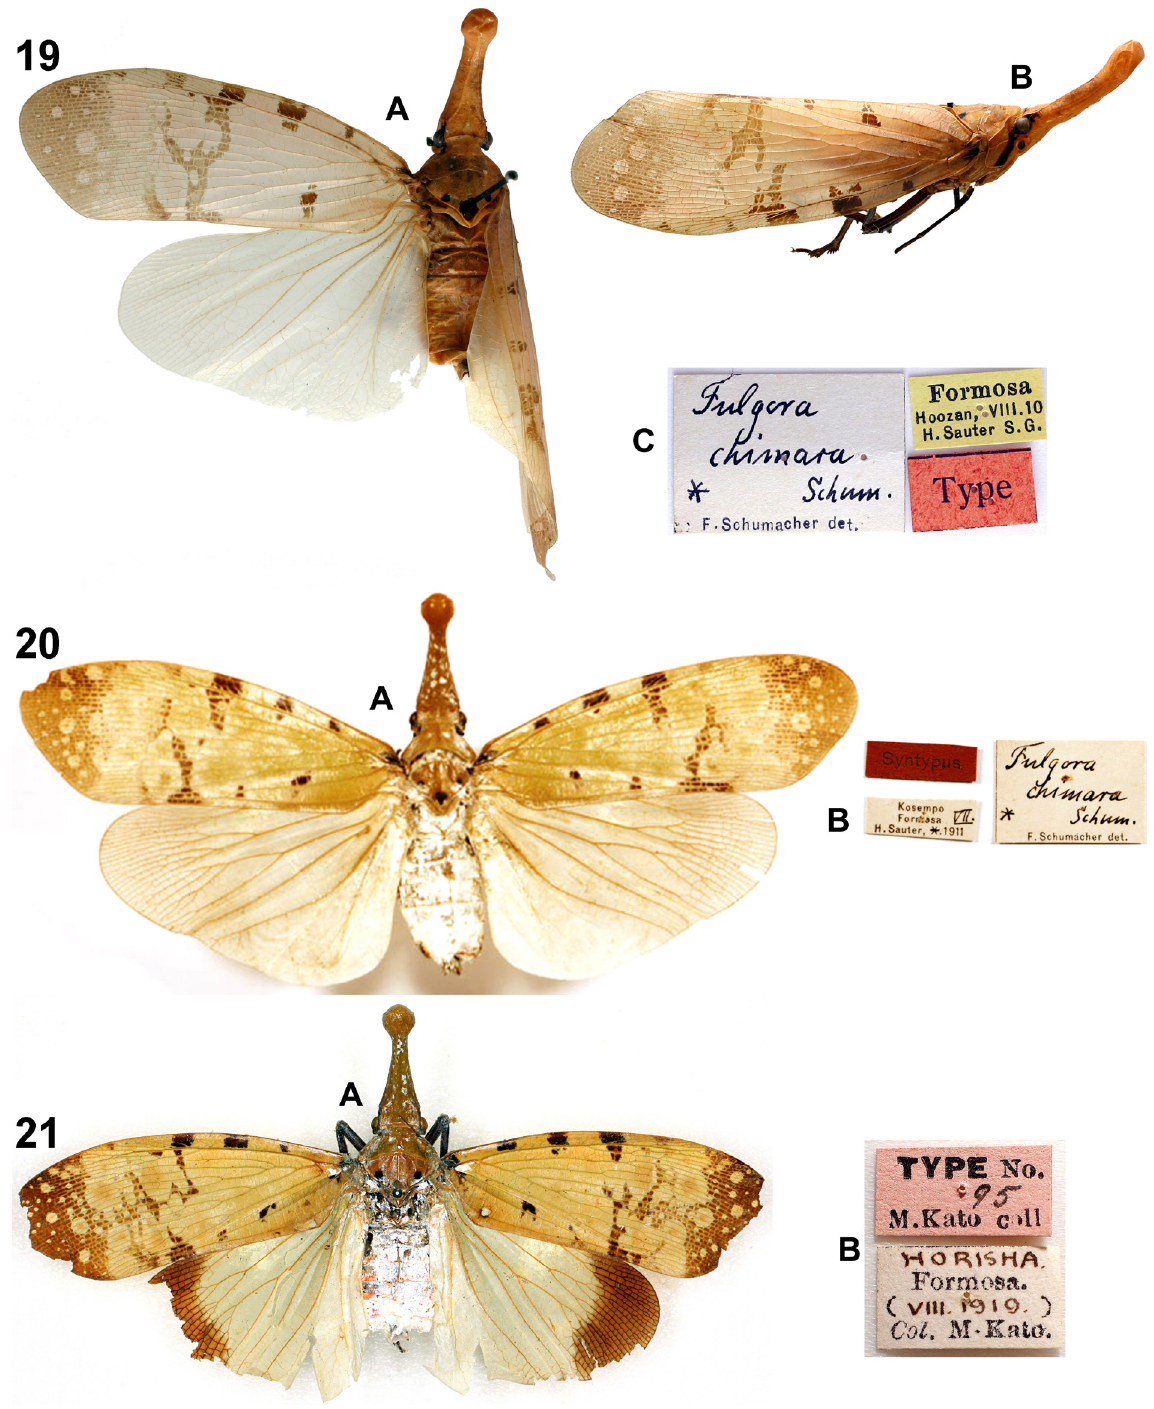
Figs 19–21. Pyrops watanabei (Matsumura, 1913), type specimens of the synonymised taxa. 19– 20 . Fulgora chimara Schumacher, 1915. 19 . Lectotype, ♀ (MFNB, photographs by J. Constant). A . Habitus, dorsal view. B . Habitus, right lateral view. C . Labels. Total length: 37 mm. 20 . Paralectotype, ♀ (photographs SDEI). A . Habitus, dorsal view. B . Labels. Wingspan: 82 mm. — 21 . Fulgora watanabei apicalis Kato, 1928, holotype, ♀ (UMUT, photographs by M. Hayashi). A . Habitus, dorsal view. B . Labels. Wingspan: